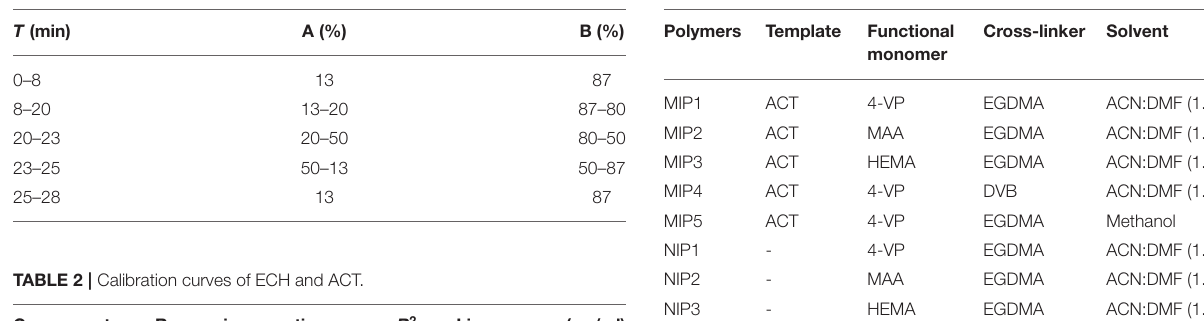
TABLE 1 | The gradient elution program of HPLC.